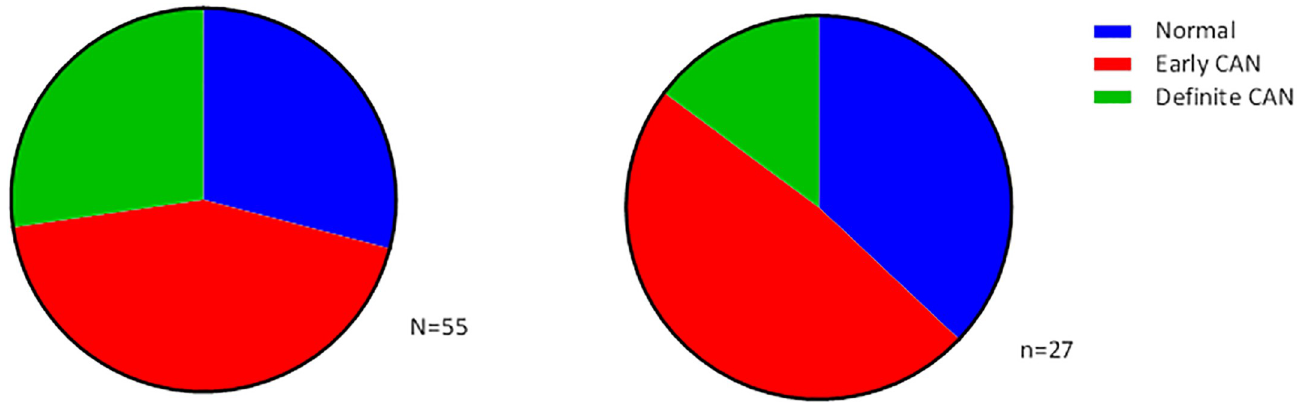
Fig 2. Prevalence of CAN in patients with and without DM. Left panel: patients with DM (n = 55), right panel: patients without DM (n = 27) p = 0.437.